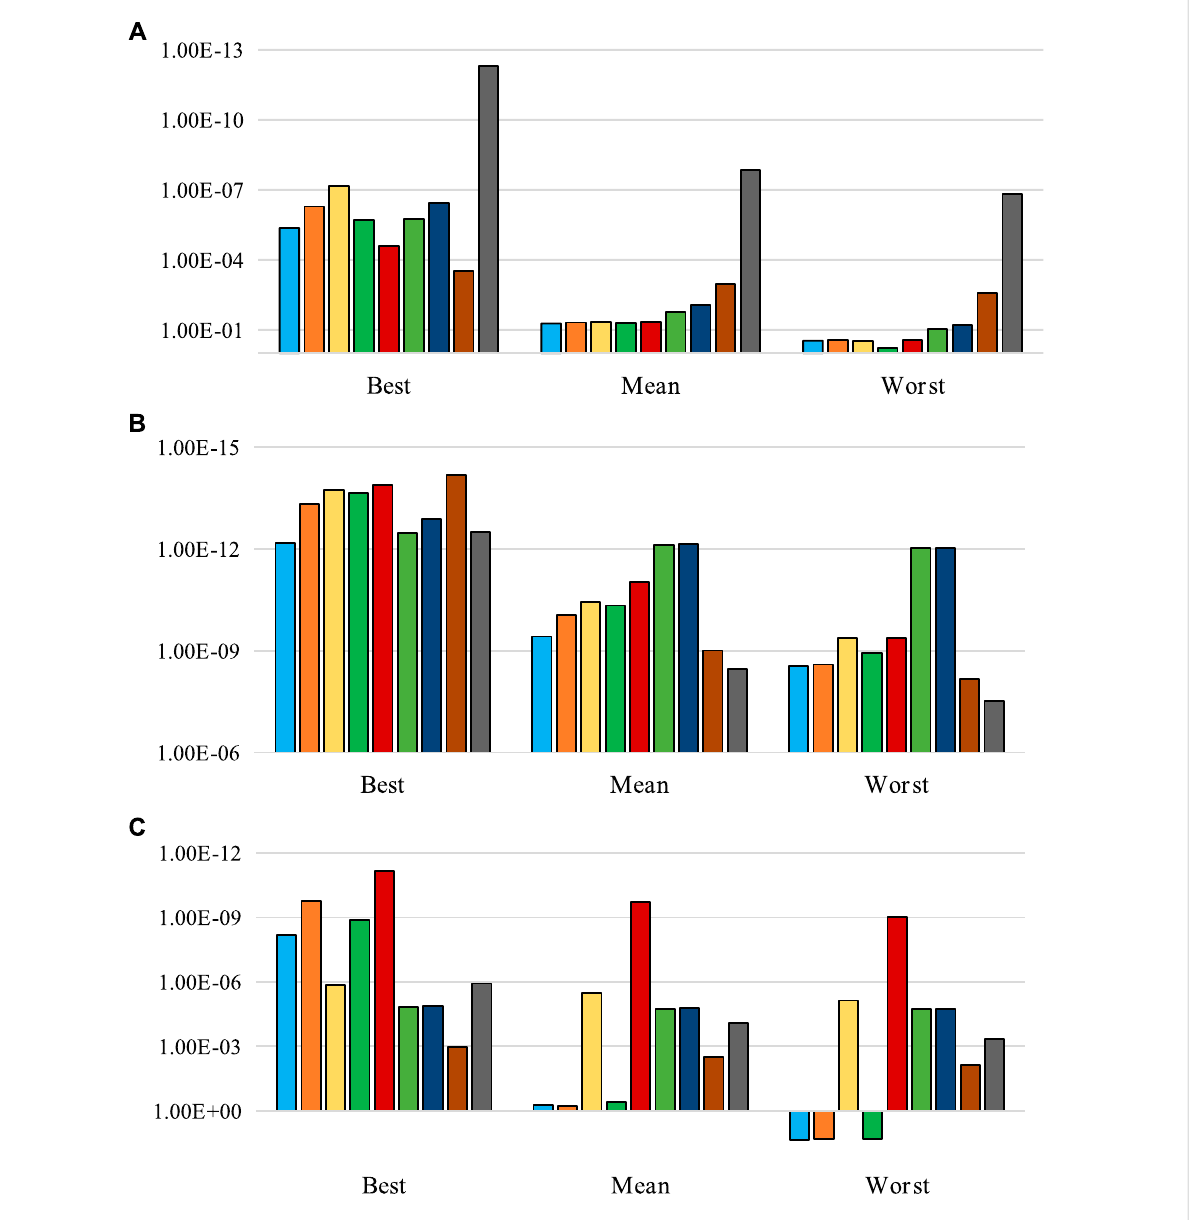
FIGURE 7 Comparisonoftheninedesignedexperimentsonthebasisoftheirbest,mean,andworst fi tnessvaluesforthesixtestfunctions(2): (A) funtion4, (B) funtion5 and (C)